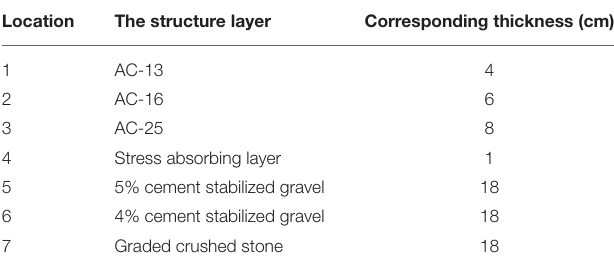
TABLE 1 | Pavement structure